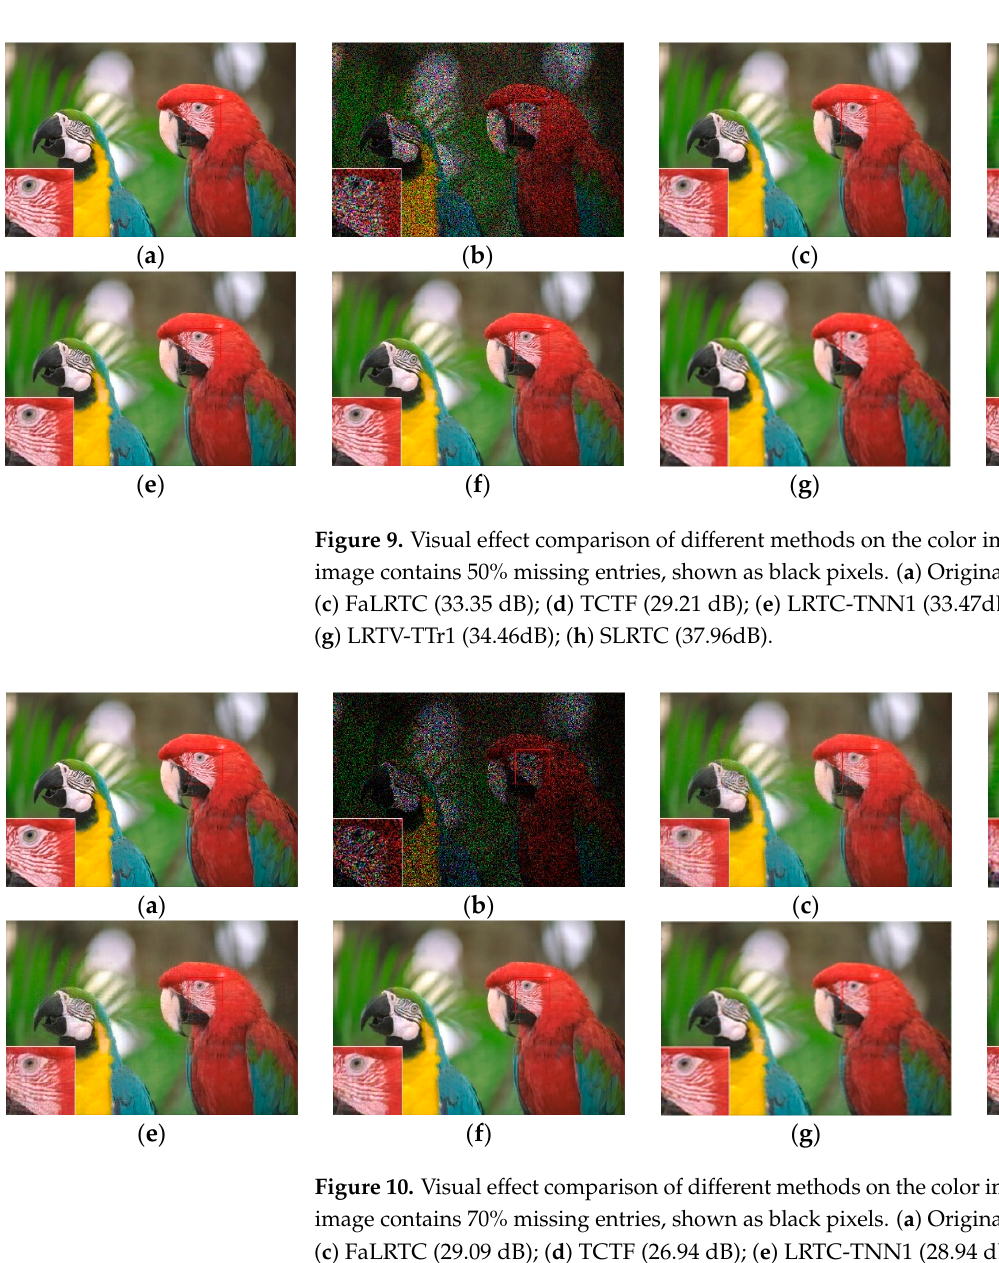
age; ( c ) FaLRTC (21.80 dB); ( d ) TCTF (19.41 dB); ( e ) LRTC-TNN1 (22.67 dB); ( f ) LRTC-TNN2 (24.59